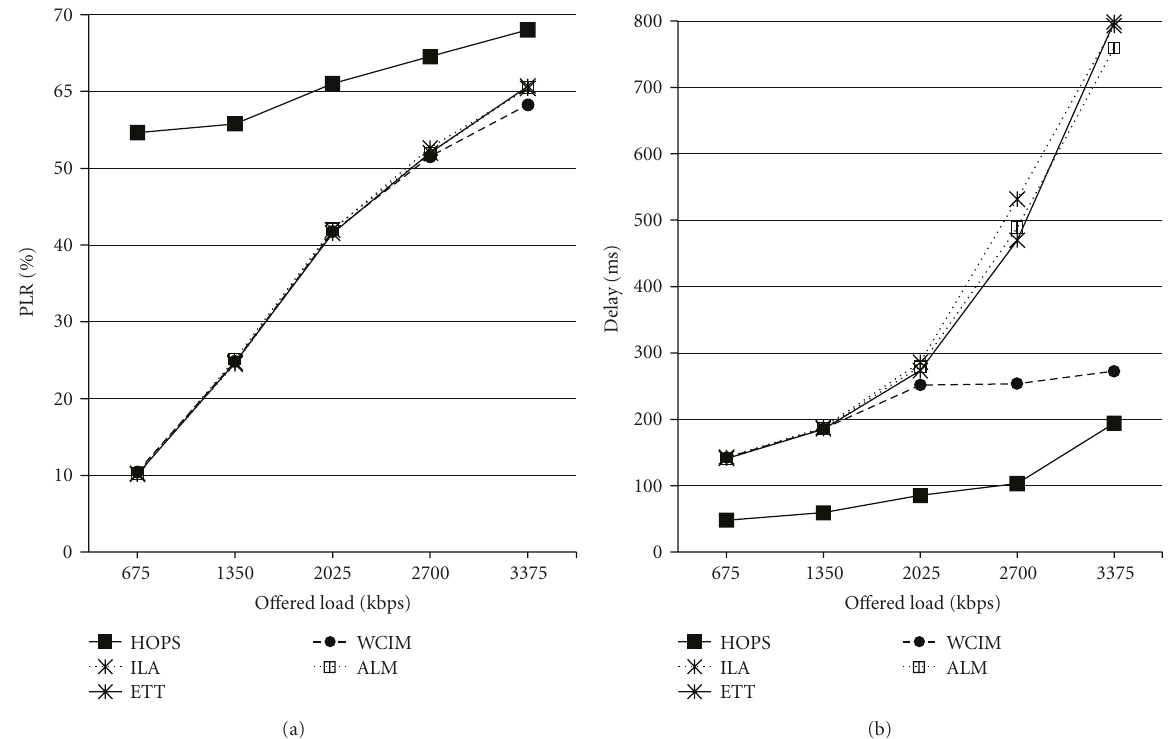
Figure 12: Scenario 6 main results. (a) Packet loss rate. (b) End-to-end delay.